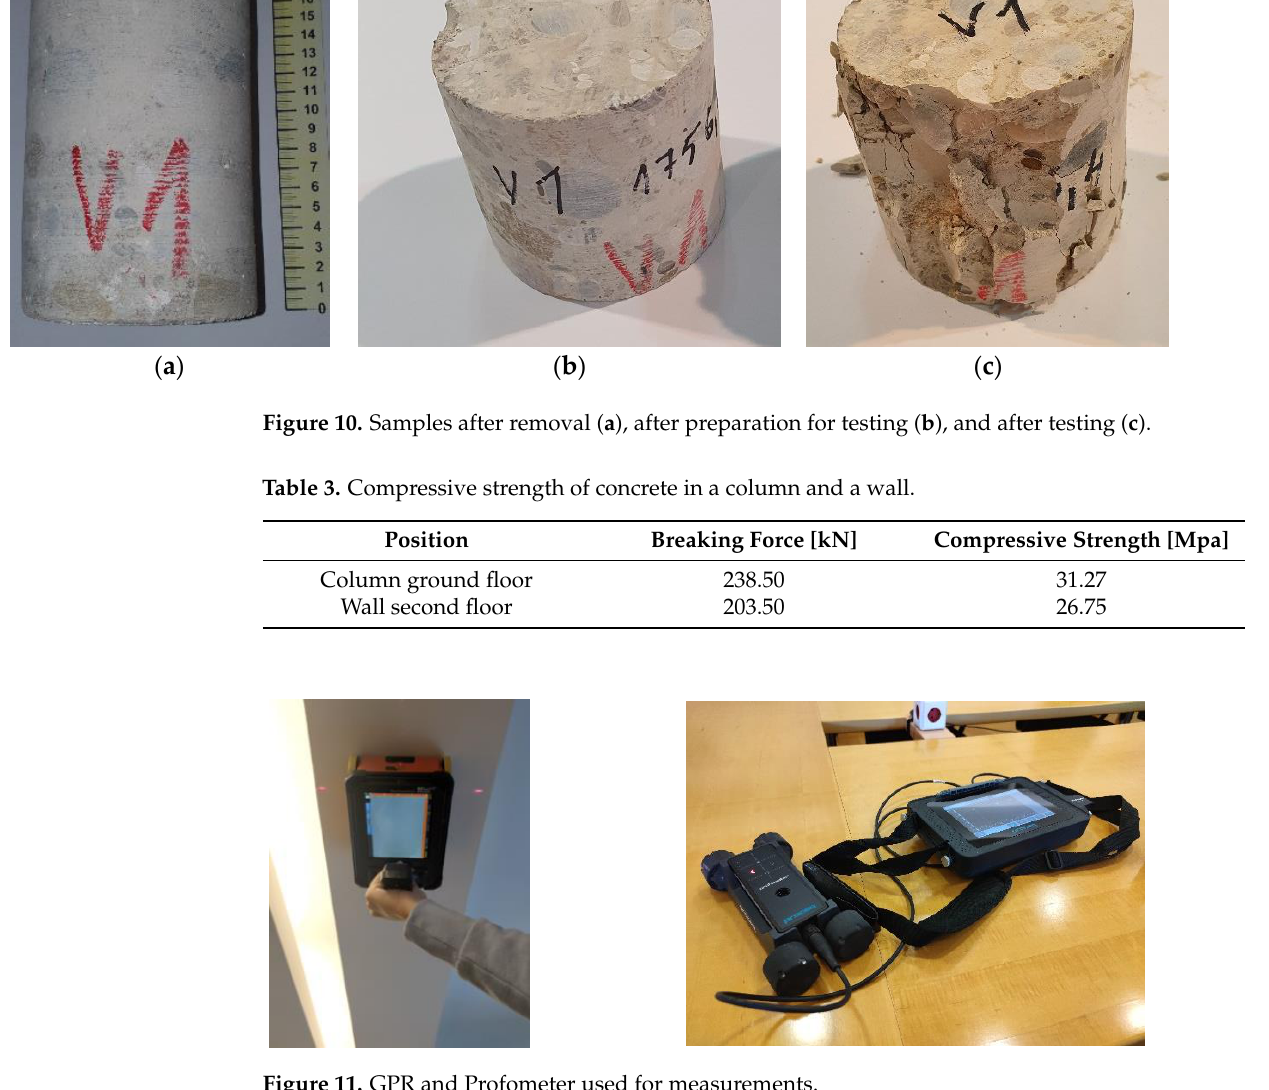
Figure 12. Radargram of built-in reinforcement